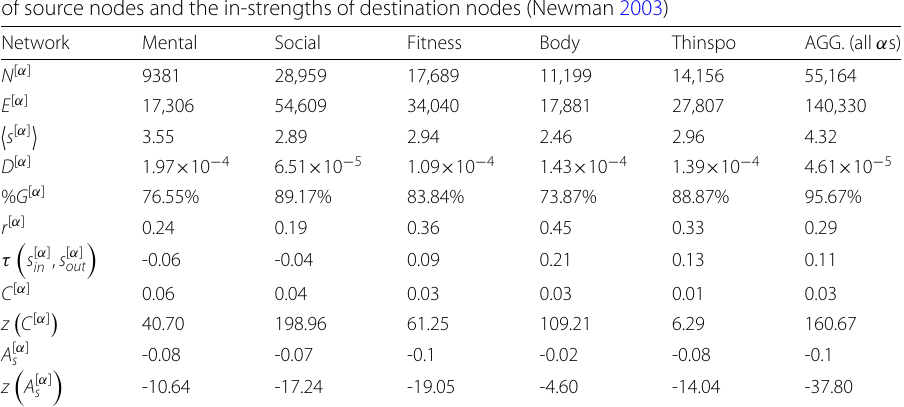
Table 1 Statistics of single-layer networks and the aggregated (AGG.) network, including 1. the number of active nodes N [ α ] , i.e., nodes that are connected by at least one in-/out-link (Nicosia and Latora 2015); 2. the total number of edges E [ α ] ; 3. the average strength measuring the ratio of the number of edges to maximum possible number of edges; 5. fraction of nodes in the giant weakly connected component % G [ α ] ; 6. reciprocity r [ α ] quantifying the likelihood of nodes with mutual links; 7. the Kendall’s τ correlation between in- and out-strengths